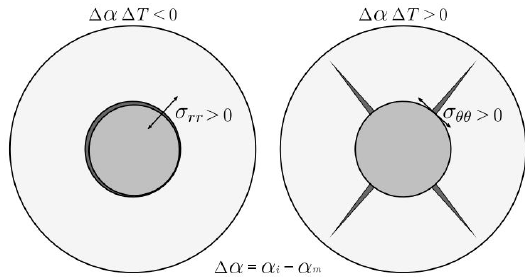
Figure 1. Influence of the CTE mismatch and temperature variation in the expected failure modes for a biphasic composite. The sub- indexes i and m are referent to the inclusion and matrix respectively. Adapted from Tessier-Doyen 7 .